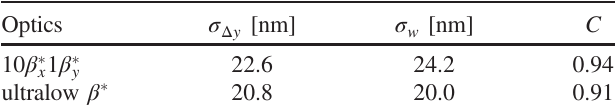
TABLE III. Major systematic errors for the IP beam size measurements in the IPBSM 174° mode with a low bunch charge (0.16 nC). The wakefield induced beam size growths are determined experimentally in the same operation weeks as the momentum bandwidth measurements. The IP position jitter and IPBSM modulation reduction factor are from analytical assess- ments concerning realistic machine parameters. Notice that these systematic errors closely depend on machine conditions and vary from one operation period to another.